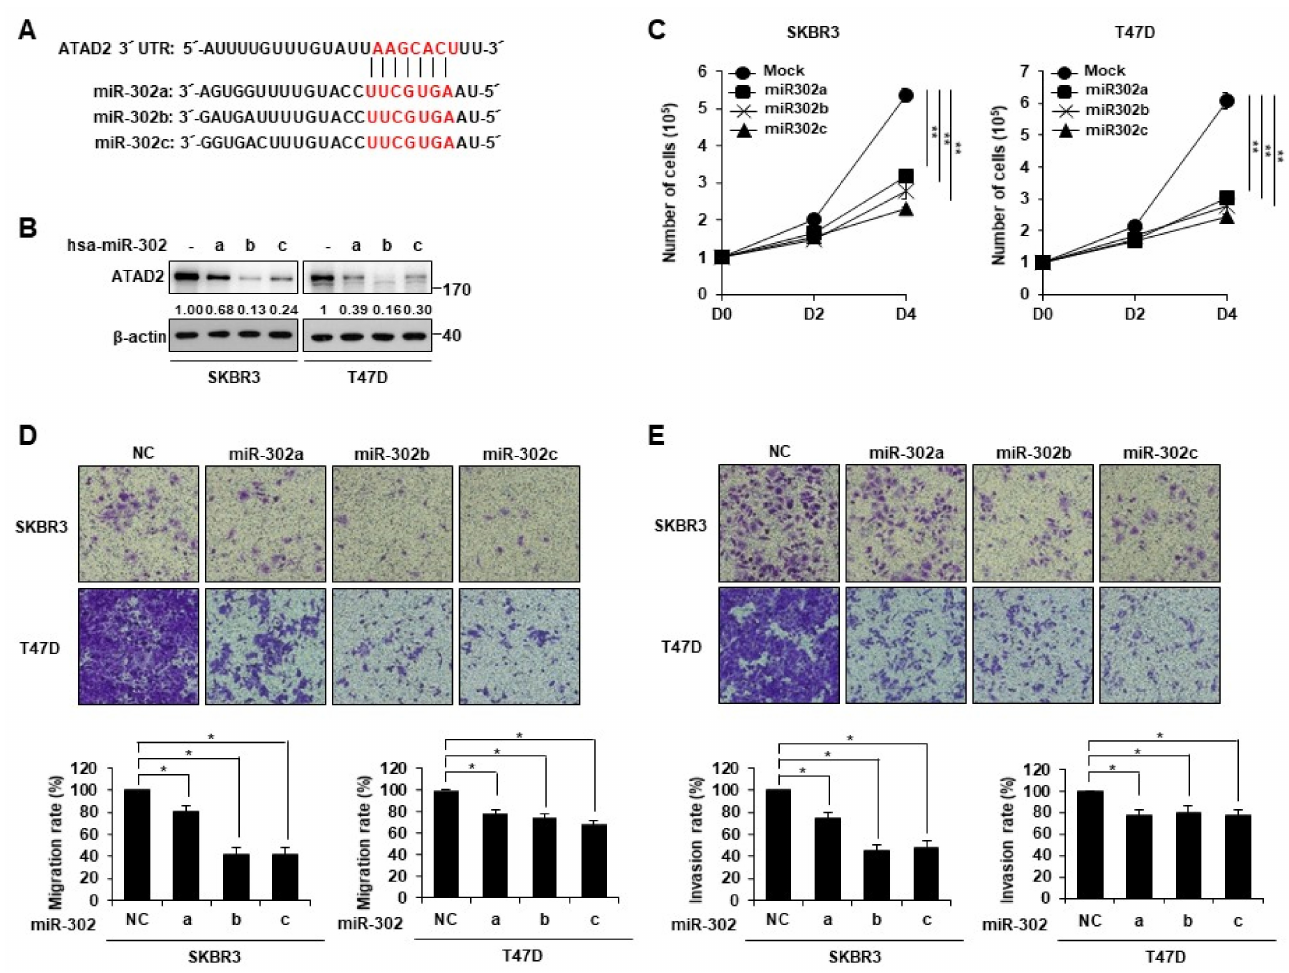
Figure 3. miR-302 family attenuates breast cancer cell migration and invasion by downregulation of ATAD2 expression. ( A ) The miR-302 family binding site was predicted at the 3 (cid:48) UTR of ATAD2 mRNA. ( B ) SKBR3 and T47D cells were transfected with 100 nM of hsa-miR-302a, b, and c mimics. Western blot analysis was performed with the ATAD2 antibody. β -actin was used as a loading control. ( C ) The proliferation of transfected SKBR3 and T47D cells with 100 nM of negative control (NC); miR302 a, b, and c were identified via cell counting after trypan blue staining at each time point. SKBR3 and T47D cells were transfected with 100 nM of negative control (NC), miR-302a, b, and c. At 24 h after transfection, cells were seeded into the upper chamber of transwell without serum, and migration ( D ) or invasion ( E ) ability of indicated cells were measured as described in Materials and Methods. Graphs represent the relative percentages of migrating or invading cells compared to the negative control. Statistical analyses were performed using paired two-tailed Student’s t